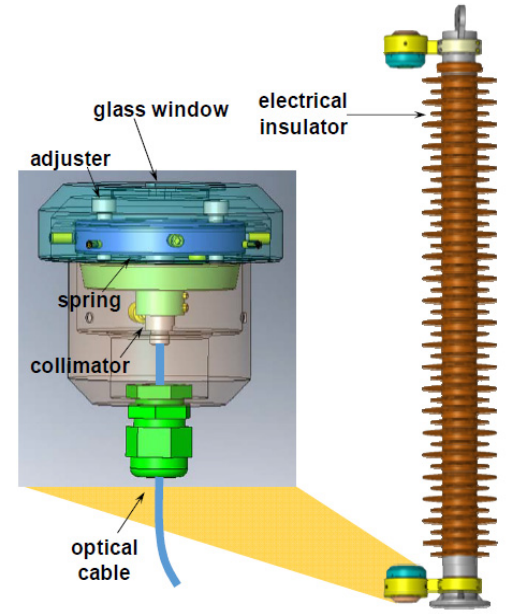
Figure 21. Optical wireless monitoring device and its main elements [77].